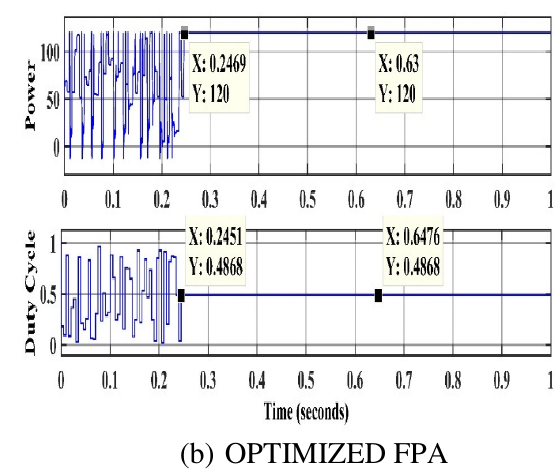
FIG. 6. GLOBAL I-V &P-V CHARACTERISTICS OF A PV ARRAY IN ZERO SHADING CONDITION